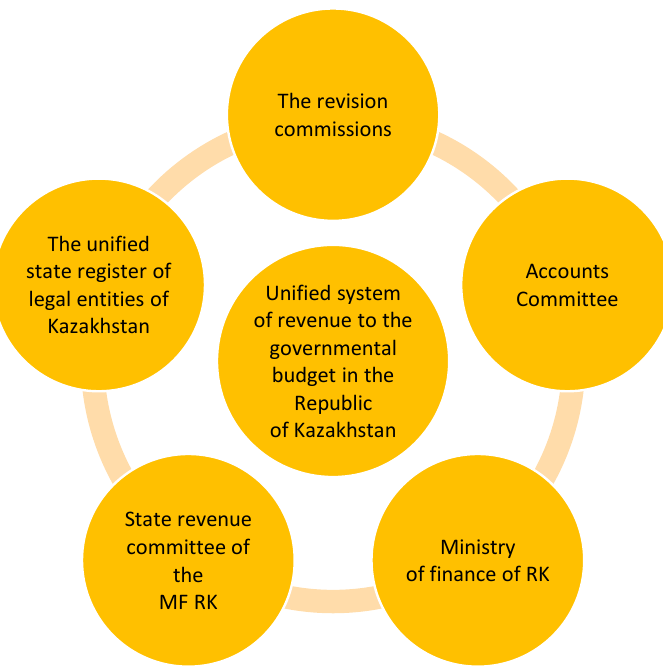
Figure 3. Partner organizational structure of tax administration in the Republic of